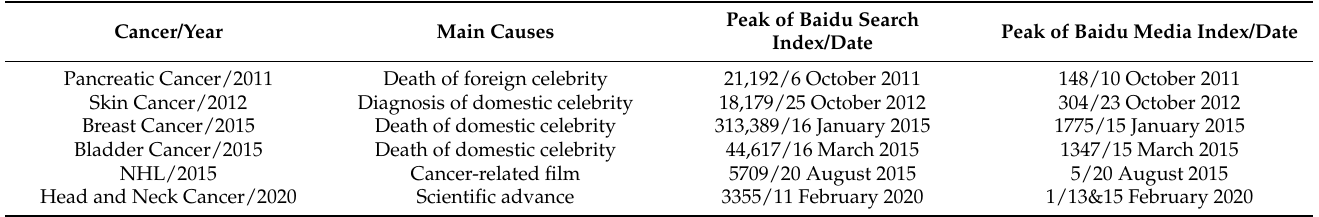
Table 4. Details about six fluctuations of the Baidu Search